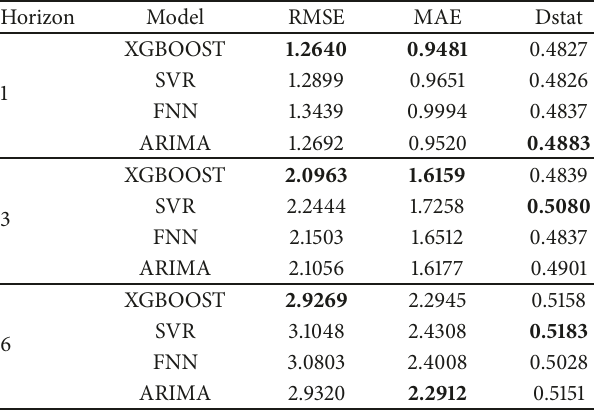
Table 2: The RMSE, MAE, and Dstat by single models with horizon = 1, 3, and